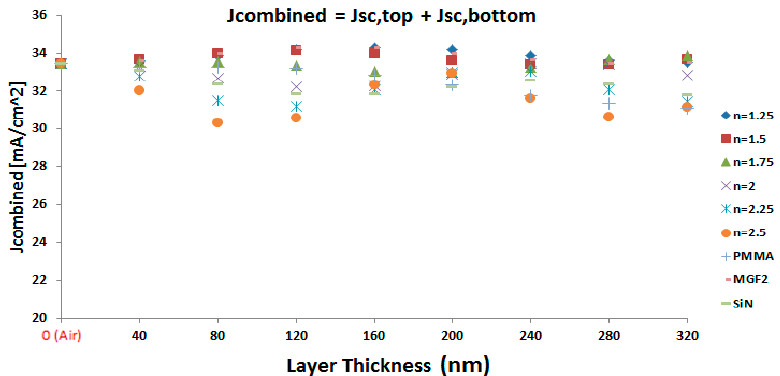
Figure 3. The sum of short-circuit current of sub-cells of tandem device is shown for optical spacers with different thickness and different refractive index’s ( n ).